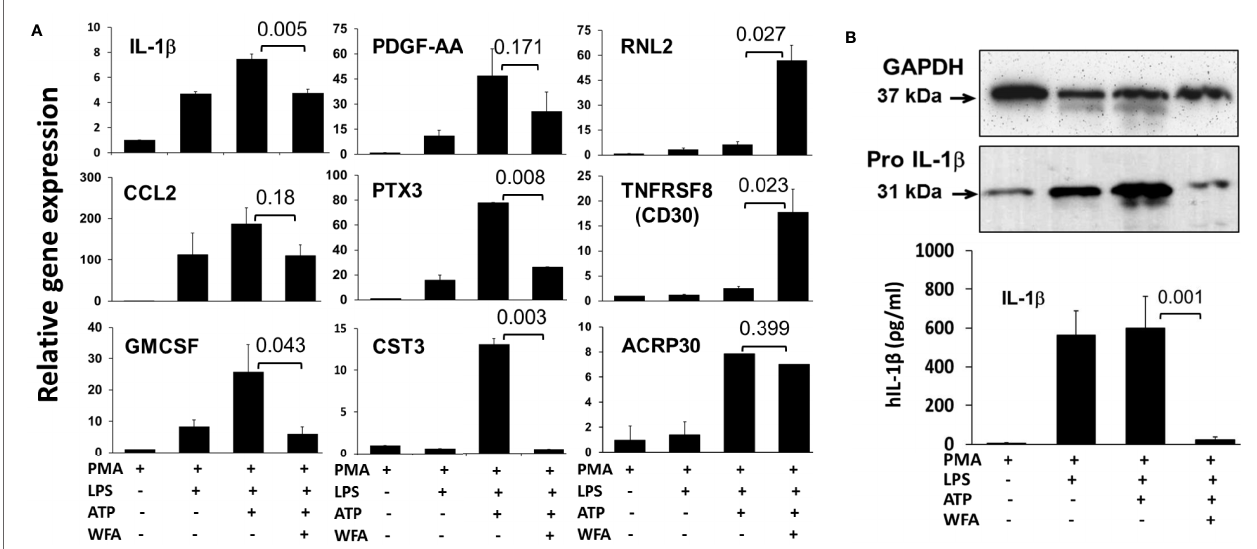
FigUre 2 | Representation of relative mRNA expression by quantitative real-time PCR (a) . Total RNA was isolated from THP-1 cells seeded as before with or without withaferin A (WFA) (20 µM) treatment and was subjected to real-time PCR to validate the differential expression of the identified cytokines. Data are presented as relative target gene expression with GAPDH normalization. (B) The validation of reduced interleukin-1 beta (IL-1 β ) by western blot on cell lysates (upper panel), and enzyme-linked immunosorbent assay in the culture supernatant (lower panel) from THP-1 cells primed with adenosine triphosphate and treated with WFA (20 µM). The experiment was repeated twice with similar results from independent cell